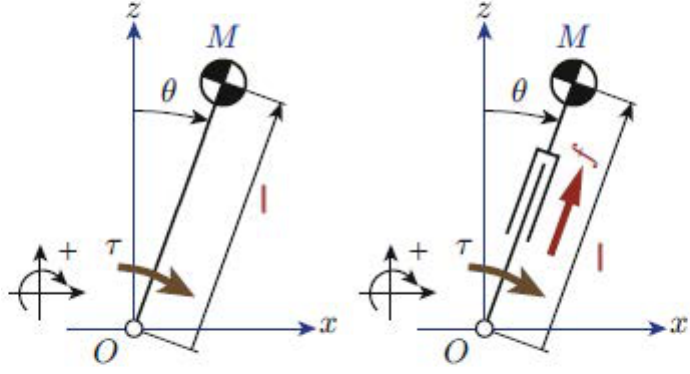
Figure 2. Basic inverted pendulum models in the x-z plane. One degree of freedom ( left ) and two degrees of freedom ( right